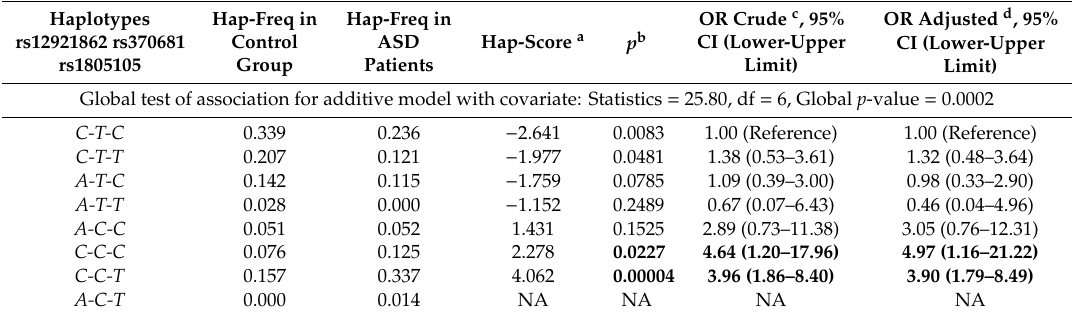
Table 4. Haplotype results for association of AXIN1 gene with ASD